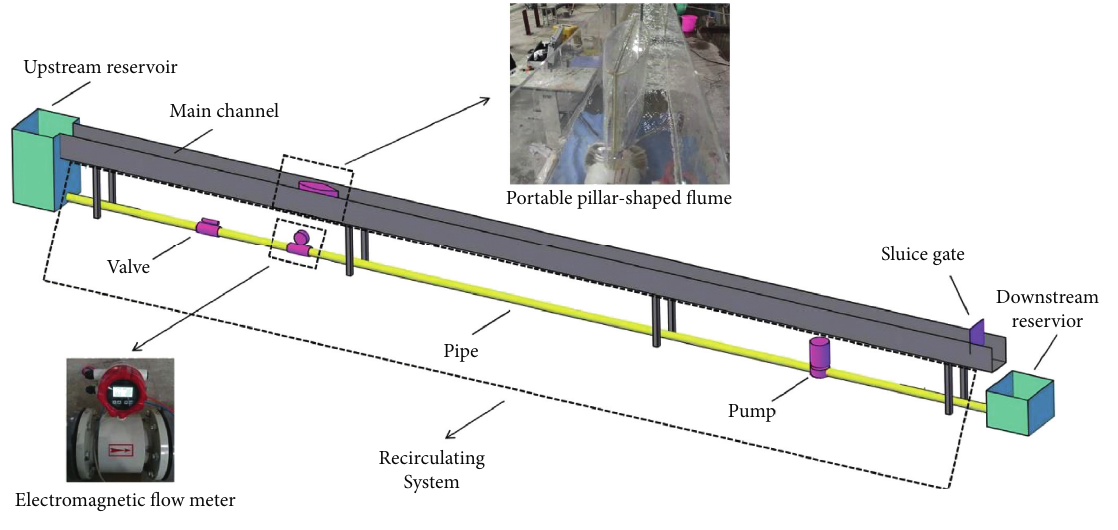
Figure 3: A sketch of the experimental setup. Table 1: Dimensions of the portable pillar-shaped flumes with different contraction ratios.